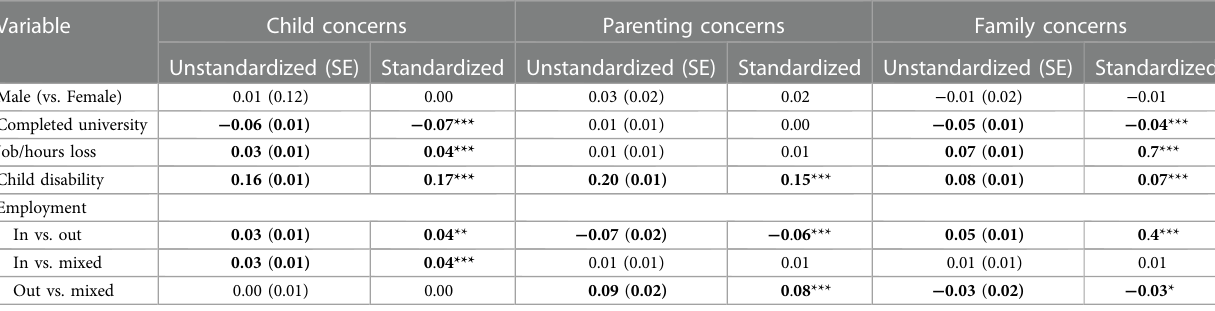
TABLE 2 Structural regression model parameter estimates for social determinants of health in association with parent-reported concerns.